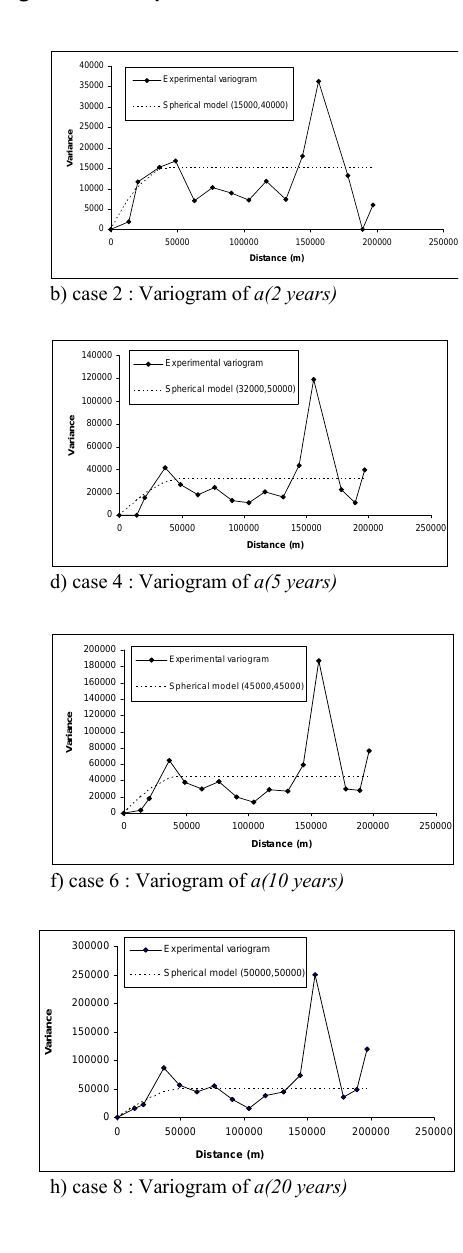
Fig. 3. Variograms of a(T ) and b(T )